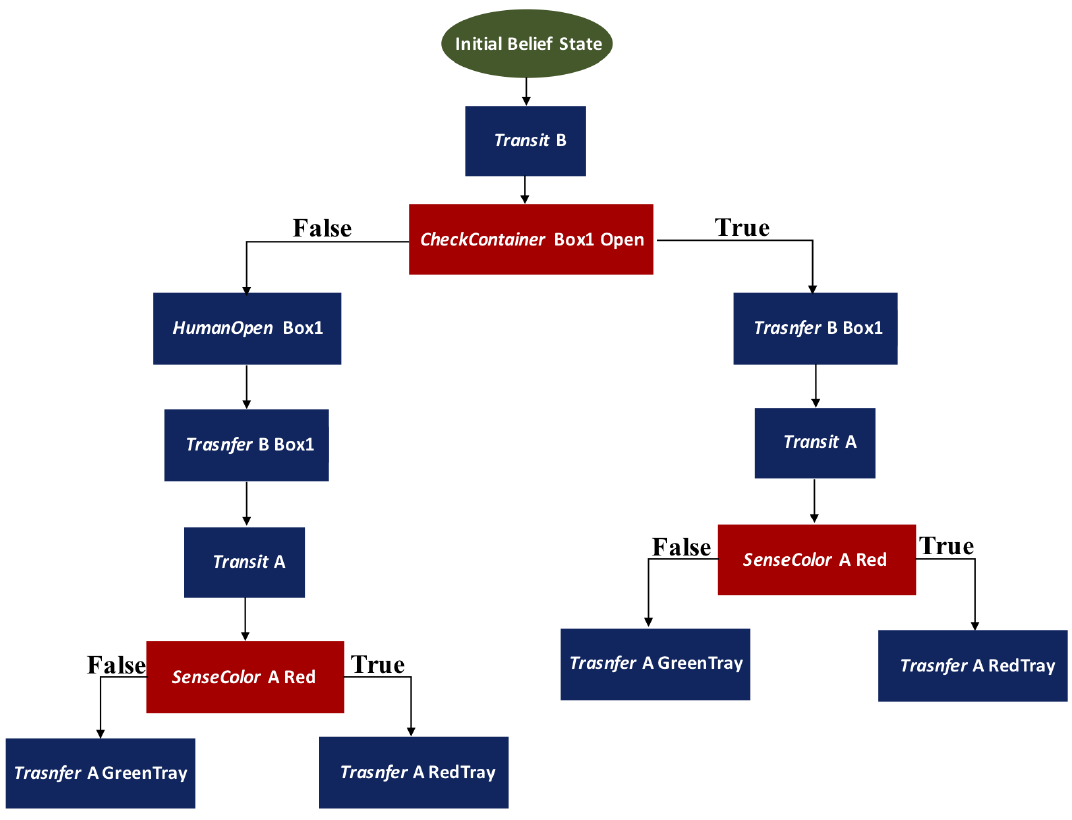
Figure 5. The conditional plan results from the proposed planning process. The actions highlighted with the blue color are the ones assigned to the robot or a human operator. Some important actions parameters are represented. The actions specified by the red color are sensing